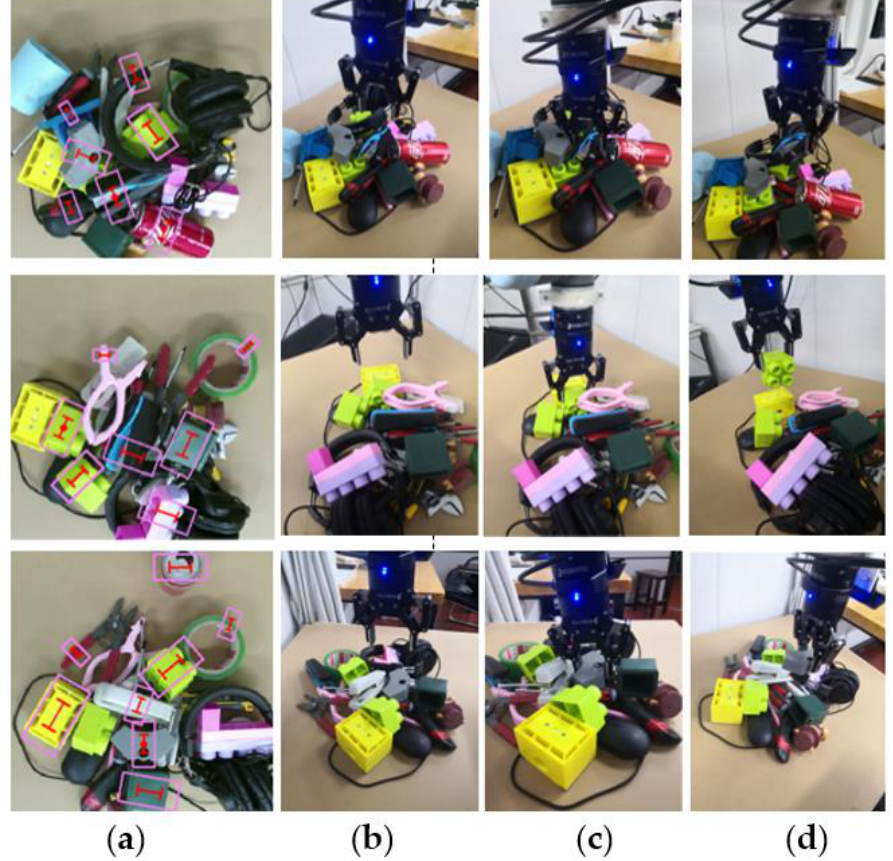
Figure 10. Robot grasping in different cluttered scenarios: ( a ) objects detection, ( b ) adaptive gripper configurations and robot approaching objects, ( c ) robot grasping the object, ( d ) robot picking up the object. Table 6. Results in cluttered scenarios.